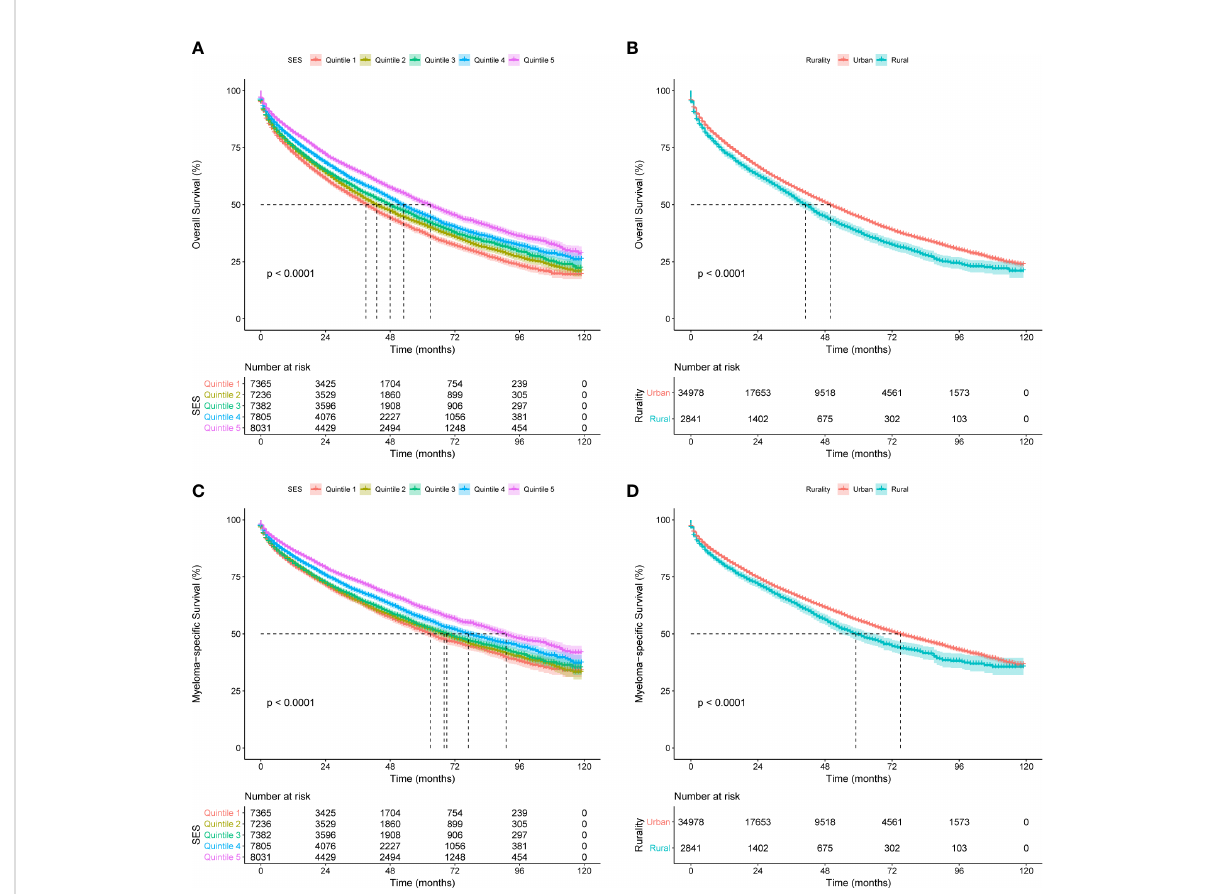
FIGURE 1 Kaplan-Meier survival curves of the SEER cohort for (A) OS strati fi ed by SES quintiles, (B) OS strati fi ed by rurality, (C) MSS strati fi ed by SES quintiles, and (D) MSS strati fi ed by